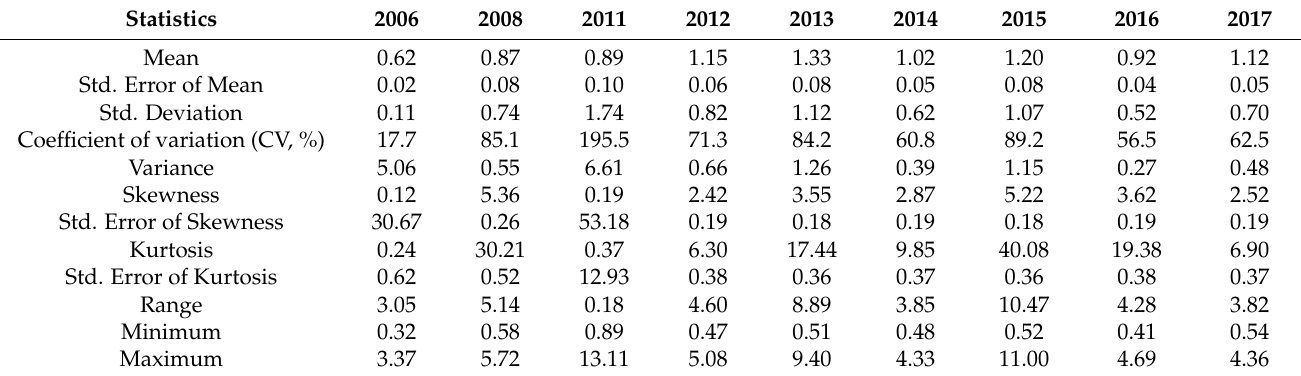
Table 2. Descriptive statistical results of soil salt content in different sample year (g kg − 1 ).